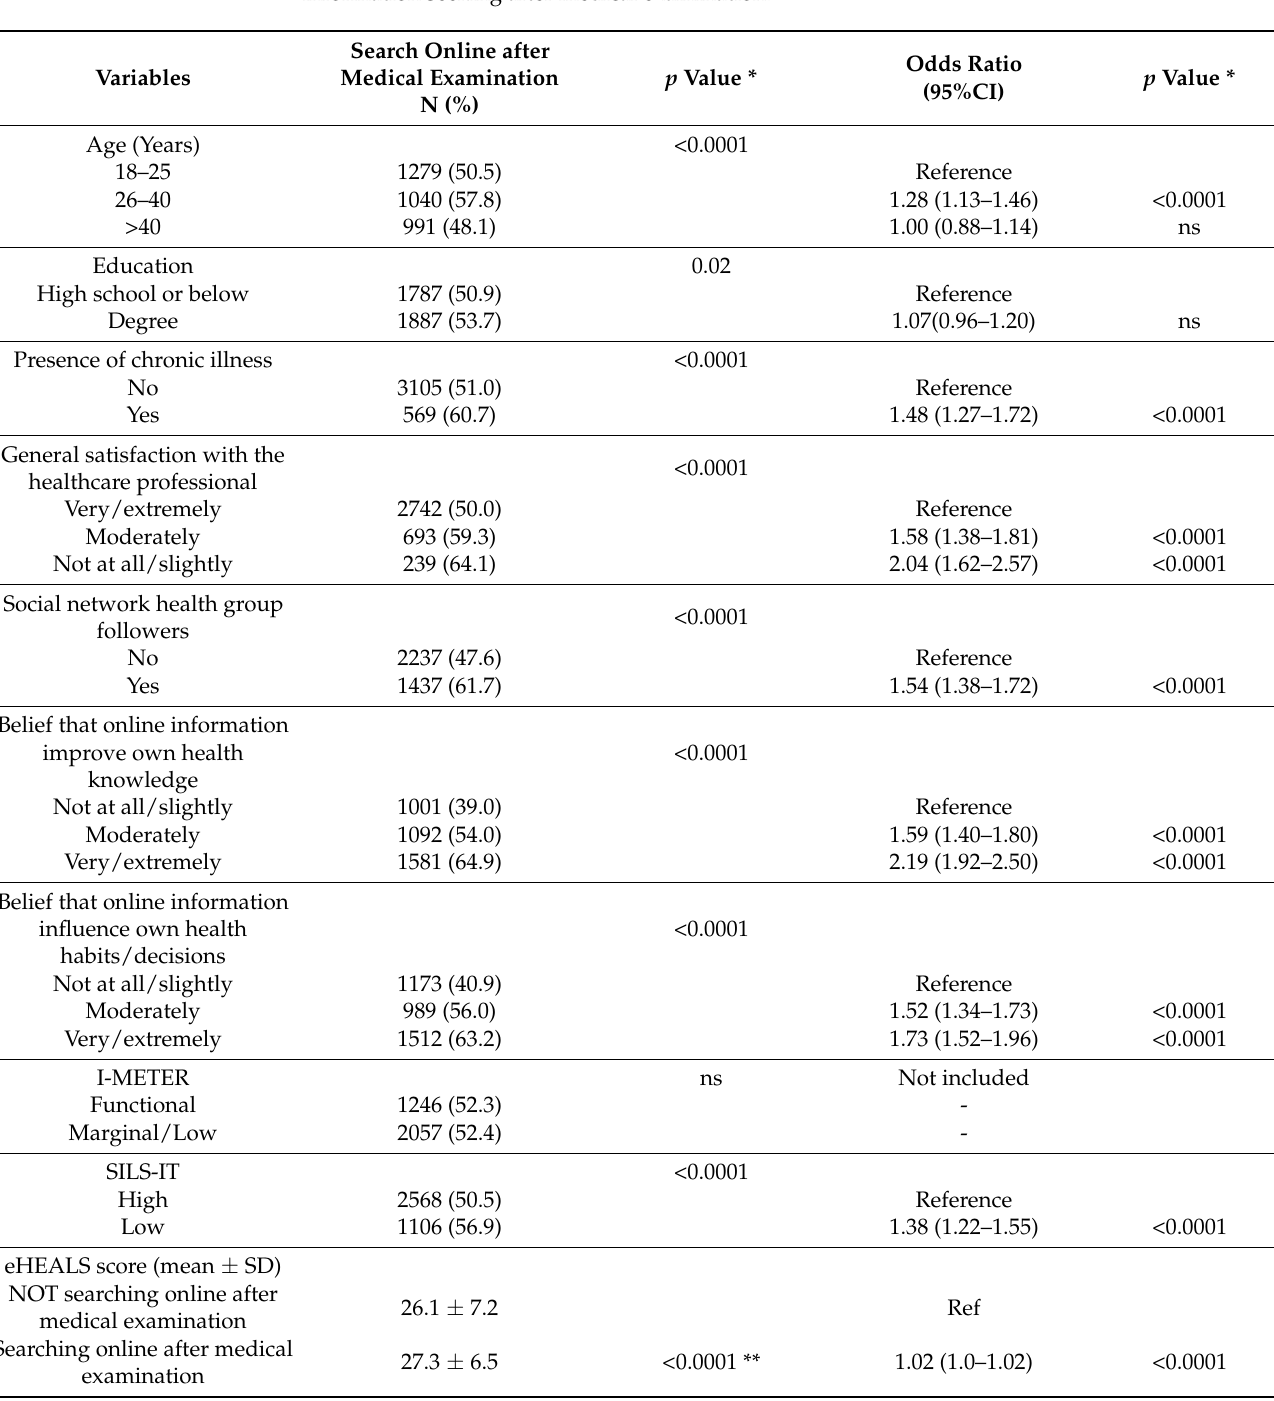
Table 4. Univariate and multivariate analysis on the association between predictors and online health information seeking after medical